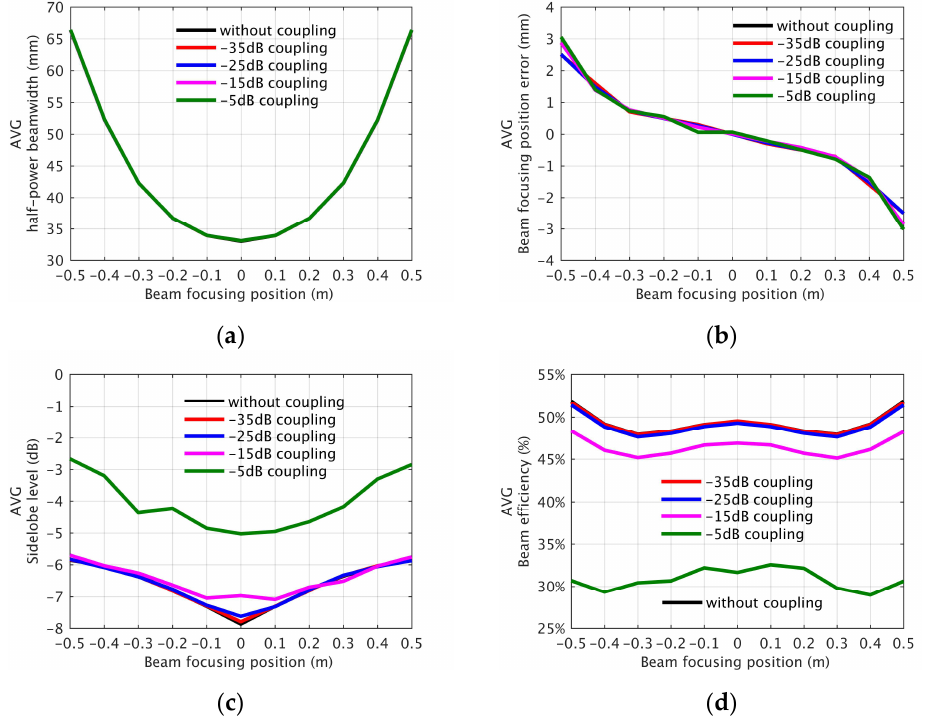
Figure 4. The mean values of repeated simulation results of beam focusing at different positions: ( a ) half-power beamwidth; ( b ) beam-focusing position error; ( c ) sidelobe level; ( d ) main beam efficiency.